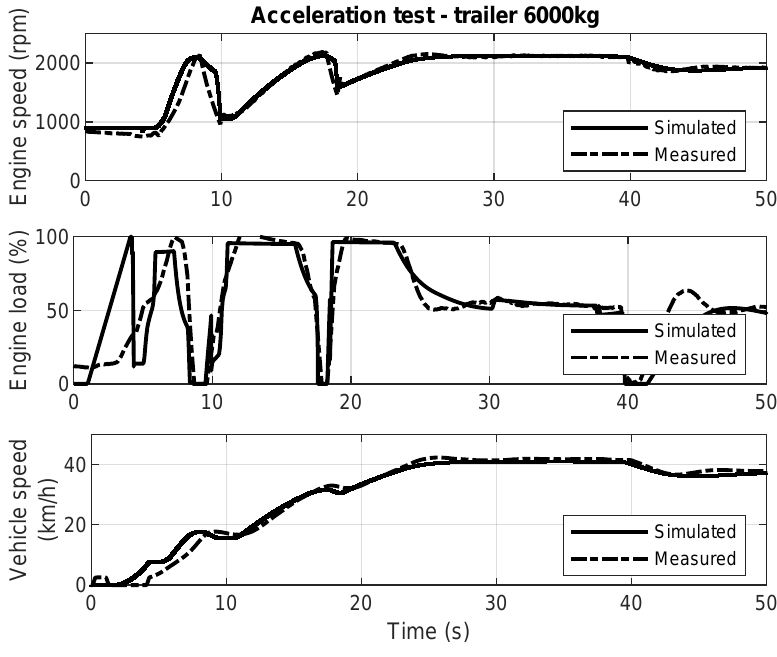
Figure 6. Performance comparison: model vs. experimental